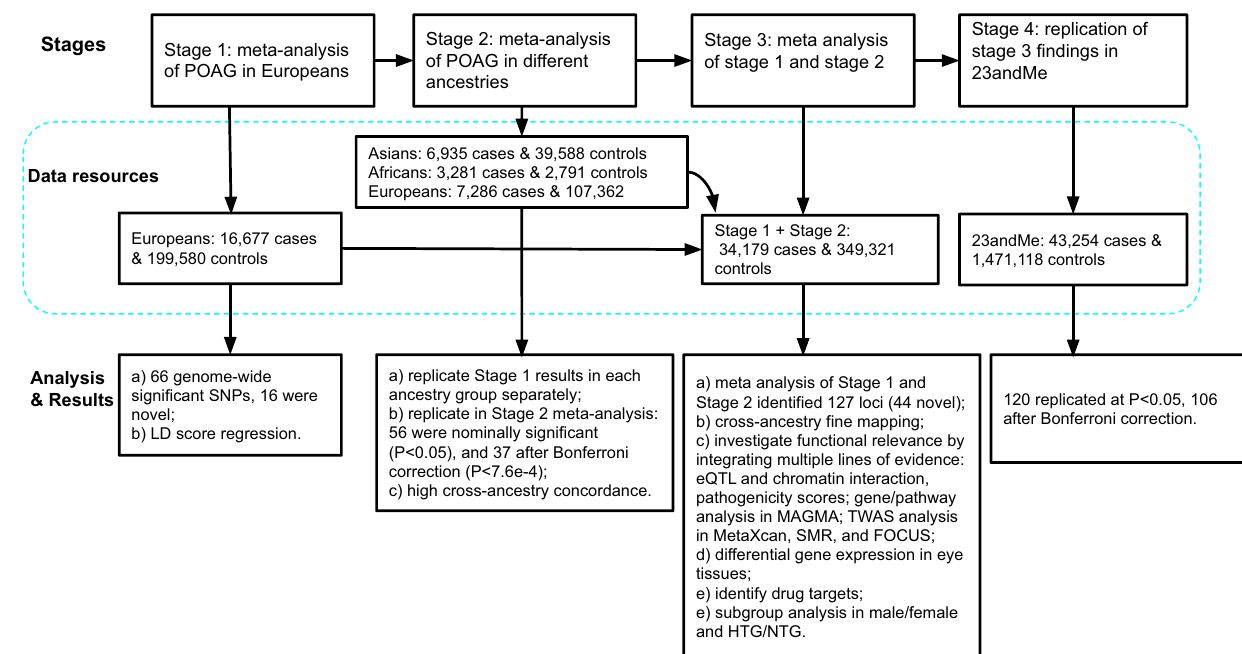
Fig. 1 Study design. This fi gure summarizes the four stages of this study, as well as the data resources and main analyses/results for each